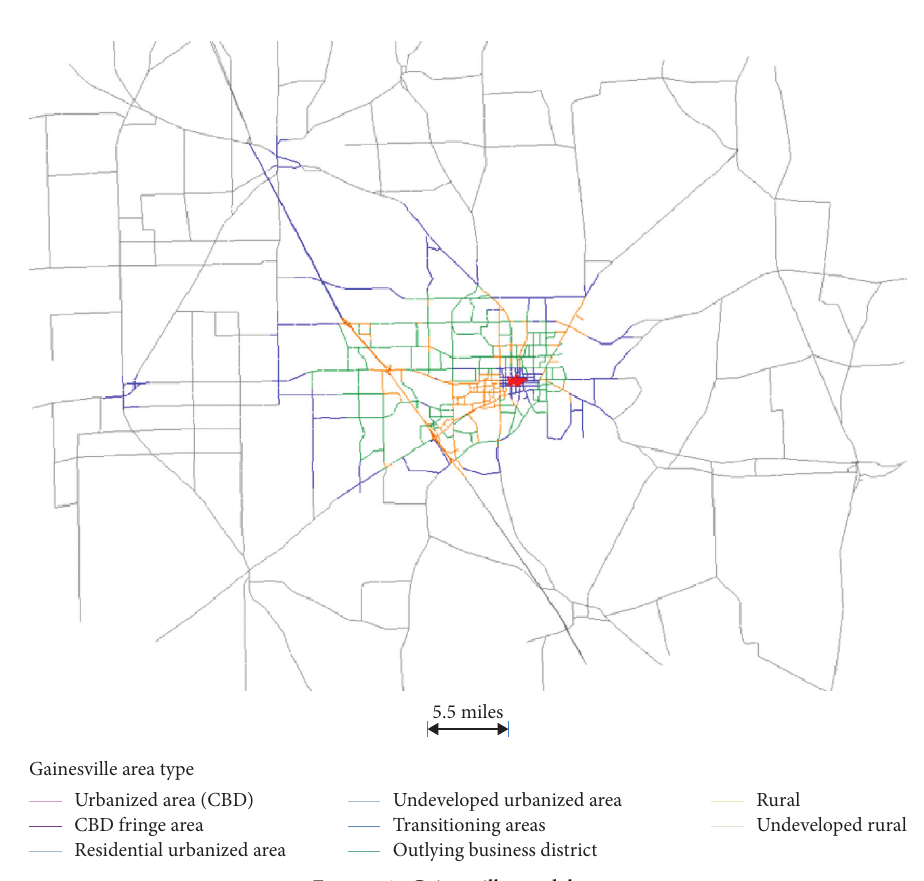
Figure 3: Gainesville model